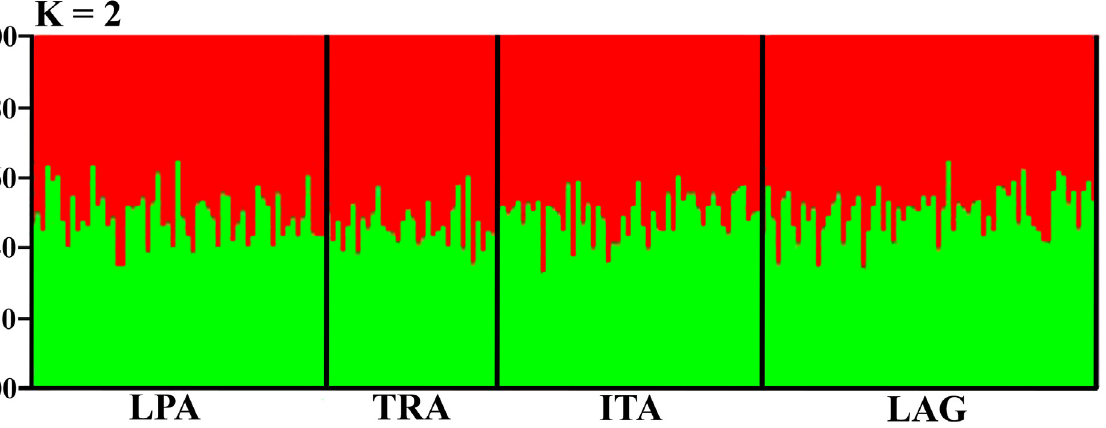
Fig 2. STRUCTURE assignment probabilities for blue crabs in South Brazil. K = 2 clusters. Each vertical bar represents one individual, and vertical black lines separate the sampled populations: LPA = Lagoa dos Patos; TRA = Tramandaí; ITA = Itajaí; LAG = Laguna.